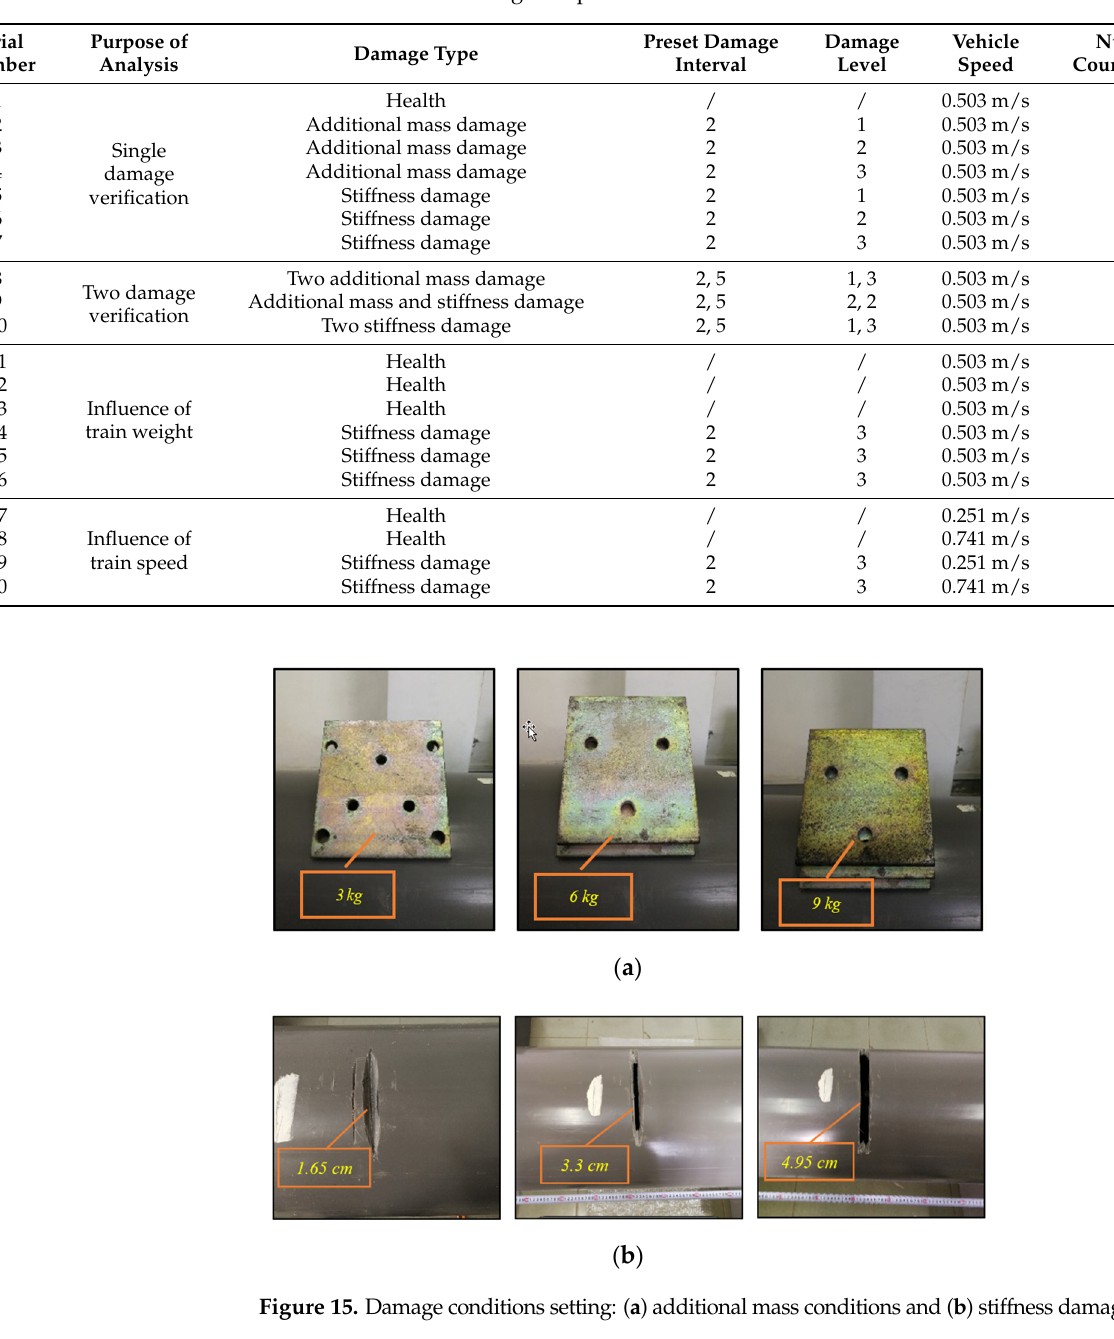
Table 4. Setting of experimental conditions.